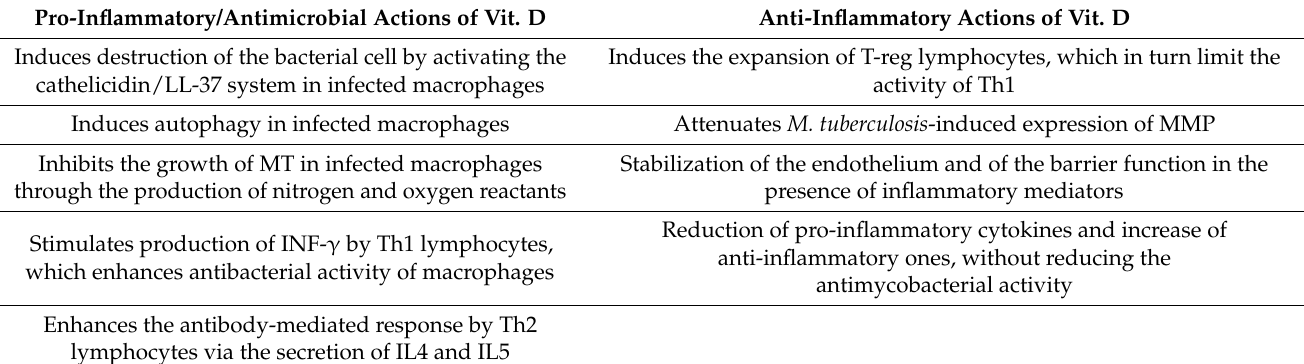
Table 2. Summary of antimicrobial and anti-inflammatory actions of Vitamin